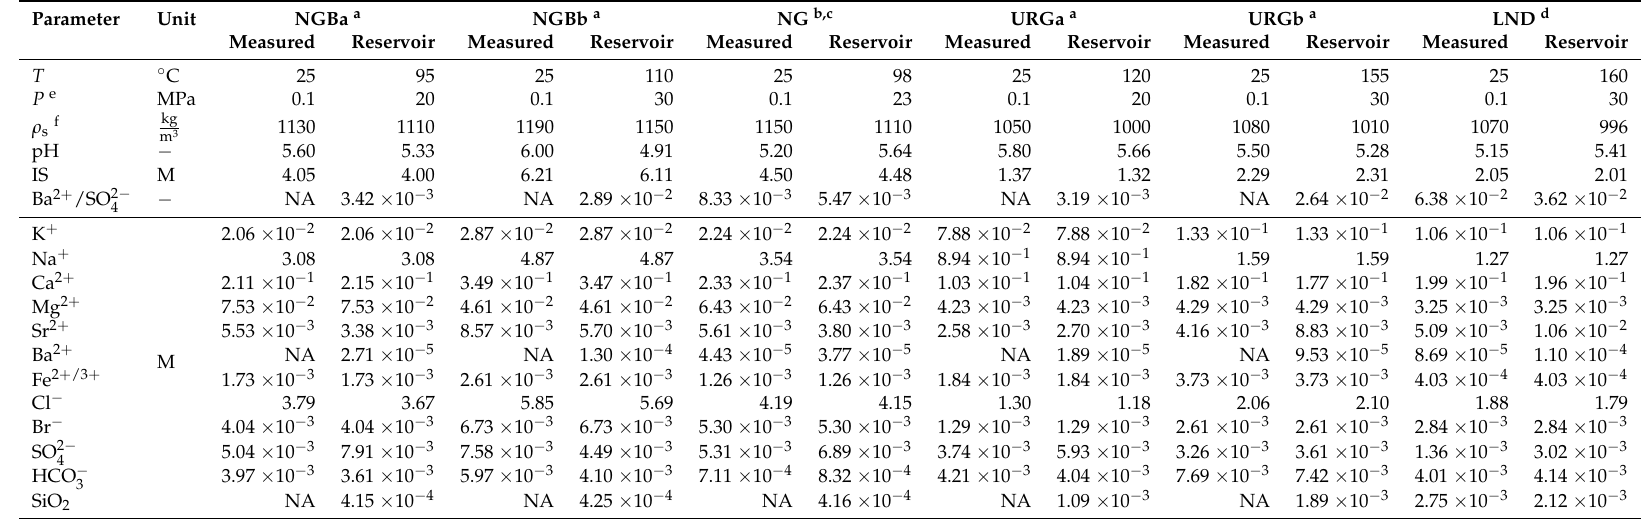
Table 1. Physicochemical parameters (upper part) and chemical composition (lower part) of the considered geothermal fluids. Measured chemical compositions are taken from given literature and converted from (mg/L) to (M) using calculated solution densities. Reservoir chemical compositions have been calculated to achieve thermodynamic equilibrium with respect to quartz, barite, anhydrite, celesite and calcite at respective reservoir conditions, using the measured values as the basis. Cl − has been additionally adjusted to achieve charge